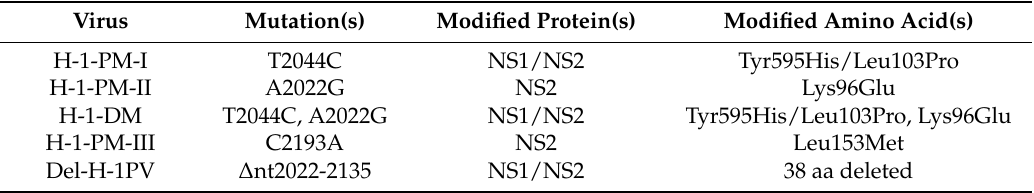
Table 1. Mutations introduced into the H-1PV genome and the corresponding modified amino acids in the NS